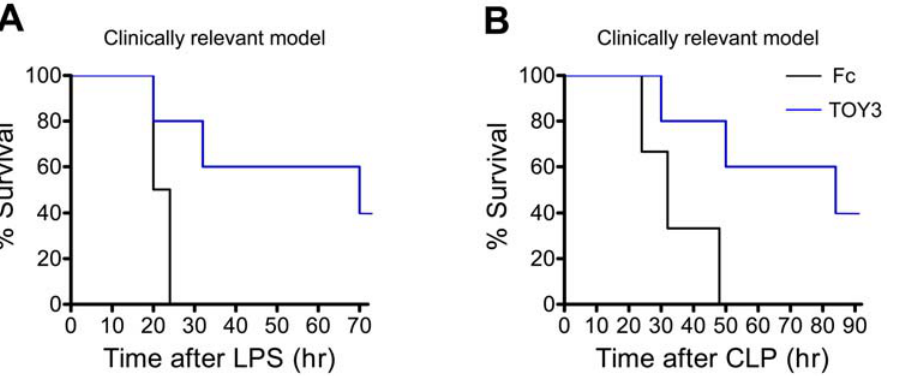
Figure 7. TOY ameliorates sepsis in clinically relevant models. ( A and B ) 20 mg/kg of Fc or TOY3 was given intraperitoneally to mice at 6 hr and 12 hr after intraperitoneal administration of LPS (15 mg/kg) ( A ) or generation of CLP ( B ). % Survival represents remaining live mice from total mice ( n =5).